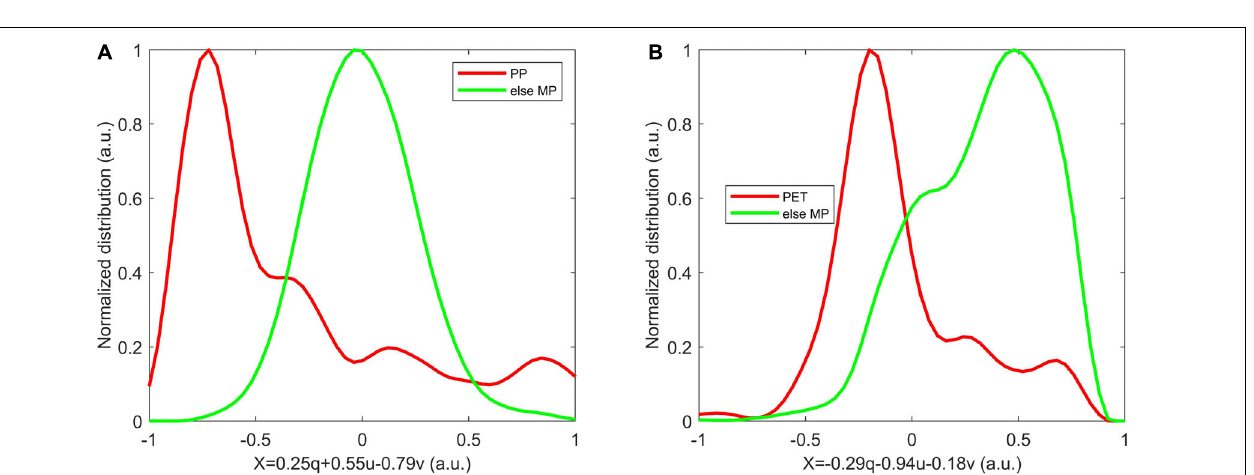
FIGURE 8 | The relationship between the polystyrene (PS) concentration and the pulse number per unit time in panel (A) the data of the mixtures of the river water and different concentrations of PS, and in panel (B) the data of the mixtures of Scenedesmus Obliquus (SO) and different concentrations of PS. (C) The PS concentration calibration relationship and the experimental data in panels (A,B) .